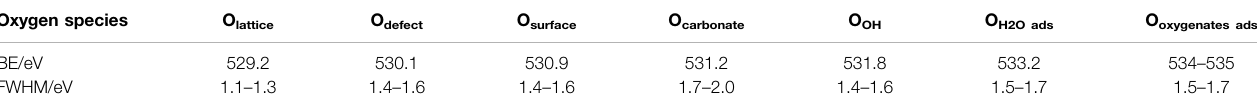
TABLE 3 | Energy positions (BE) of oxygen species in O 1s spectra and applied peak width (FWHM) for fi tting all O 1s spectra (Koch et al., 2020). Oxygen species O lattice O defect O surface O carbonate